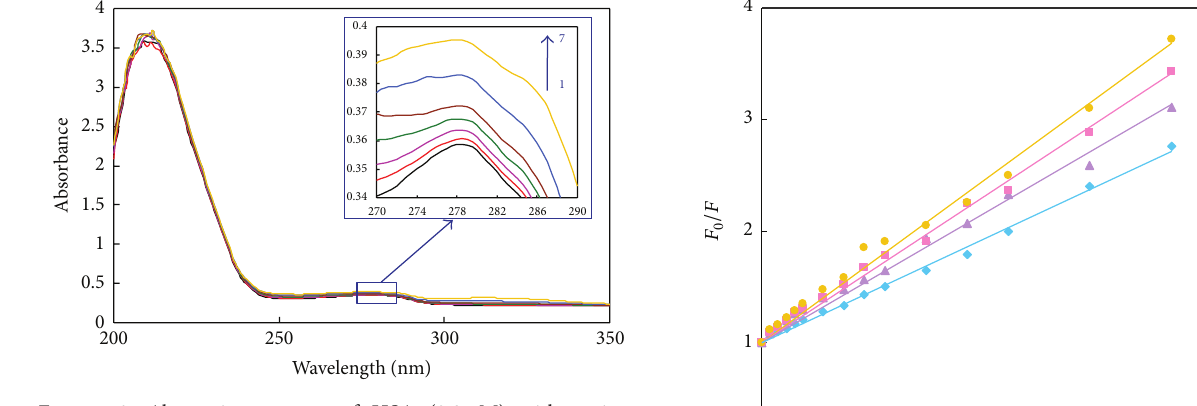
Figure 2: Absorption spectra of HSA (3.0 𝜇 M) with various amounts of isoimperatorin: (1–7) 0, 0.4, 0.8, 2, 4, 6, and 8 𝜇 M. The absorption of each sample was measured with respect to the respective blank.